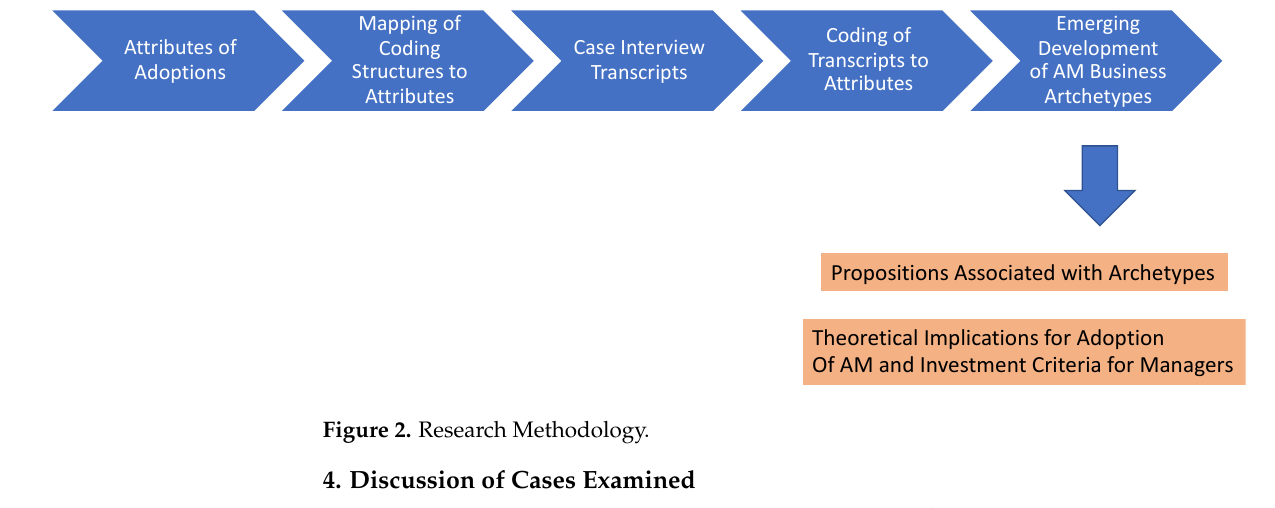
Figure 2. Research Methodology.